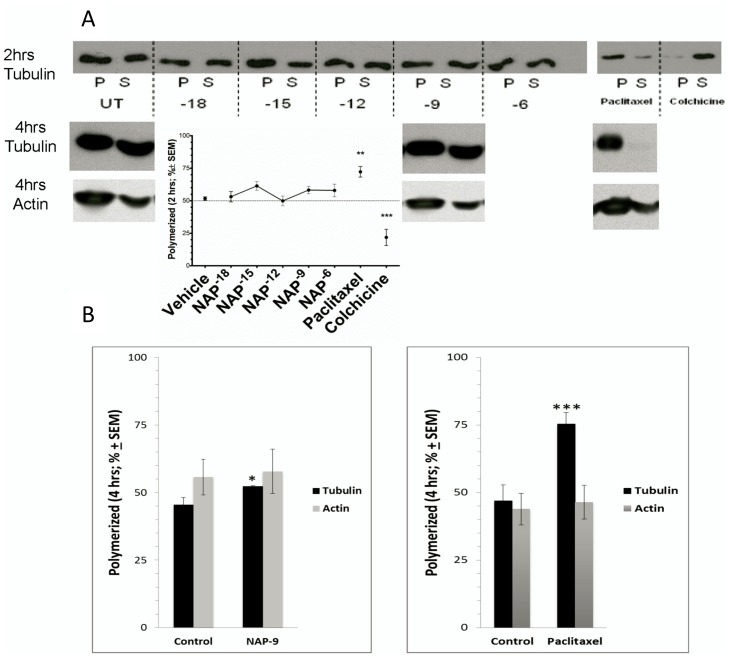
NAP effect on the polymerized tubulin fraction in PC12 cells.PC12 cells were treated for 2 hrs with either NAP (10−18M - 10−6M) or vehicle, and control compounds paclitaxel, 5 µM and colchicine, 2 µM. An additional time point (4 hrs.) was included as well for NAP (10−9M), vehicle and paclitaxel, 5 µM. (a) Cell lysates were separated into polymerized (P) or soluble (S) protein fractions. Aliquots of equal volume for each pair were resolved on adjacent lanes by SDS polyacrylamide gel electrophoresis, the blot probed with anti α-tubulin (2 hrs.) and with anti actin. The intensity of each band was quantified by densitometry and the percentage of polymerized MT was calculated by dividing the densitometric value of polymerized tubulin (P) by the total tubulin content (the sum of P plus S) in the 2 hr-incubation period and plotted as a line graph (ANOVA, p = 0.1868, n = 7). (b) The 4 hr-incubation samples shown in (a) were subjected to densitometry as above and the data plotted in bar graphs. Pairs of treatment were compared for each of the variables tubulin, actin (t-test p<0.05; ***p<0.005, n = 3).